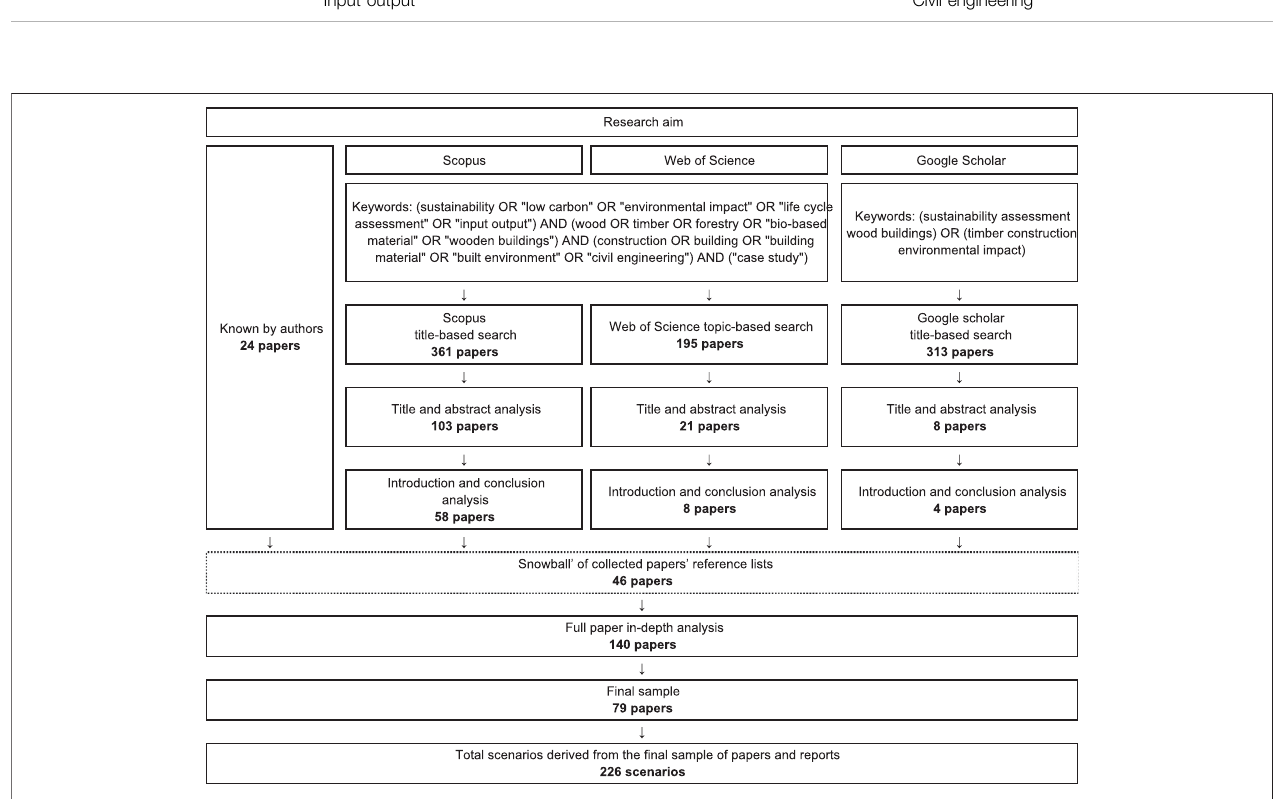
FIGURE 3 | Overview of systematic literature search and data